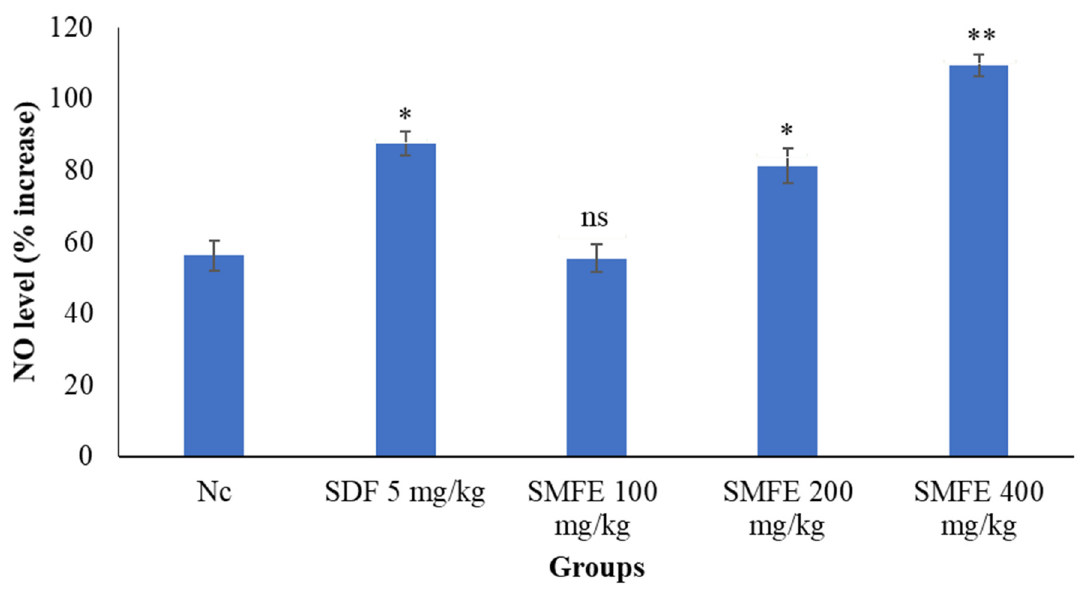
Figure 12. Effect of S. mangifera fruit extract on NO level ( n = 6). The values are means ± SEM; * p < 0.05, ** p < 0.1; ns p > 0.05 (followed by Student Dunnett test).